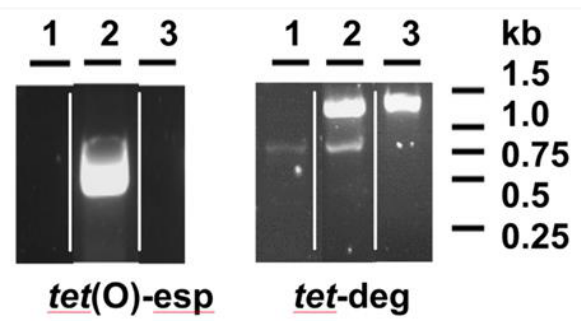
(Table S1) was positive.